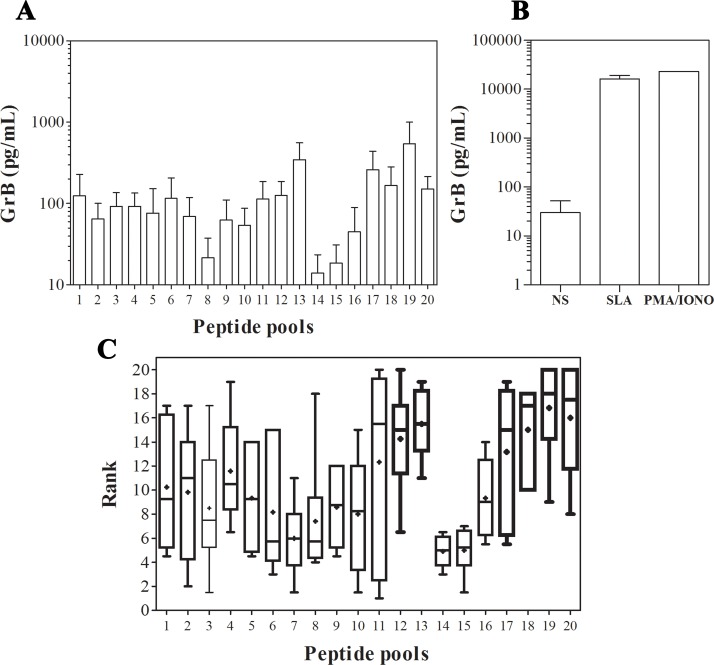
Peptides grouped in pools induced GrB production.(A) PBMCs from 5 HLA-A*0201+-donors with a history of ZCL in response to stimulation with peptide pools at a final concentration of 1μg/mL per peptide or (B) SLA (10μg/mL) and PMA/Ionomycin (10ng/mL and 50ng/mL, respectively) as positive controls. GrB production was assessed in culture supernatants using ELISA. (C) Rank of the peptide pools. +: mean pool rank, -: median.